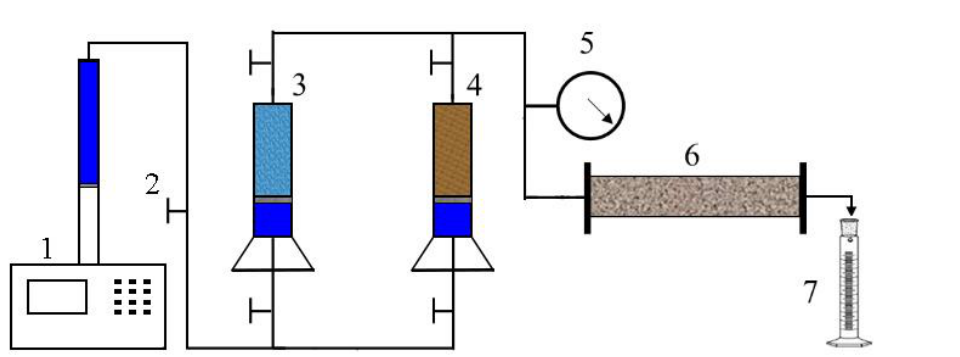
Figure 2. Schematic of the experimental set-up: 1—pump, 2—valve, 3—brine water container, 4—treatment fluid contianer, 5—pressure meter, 6—sand pack, and 7—graduated cylinder.